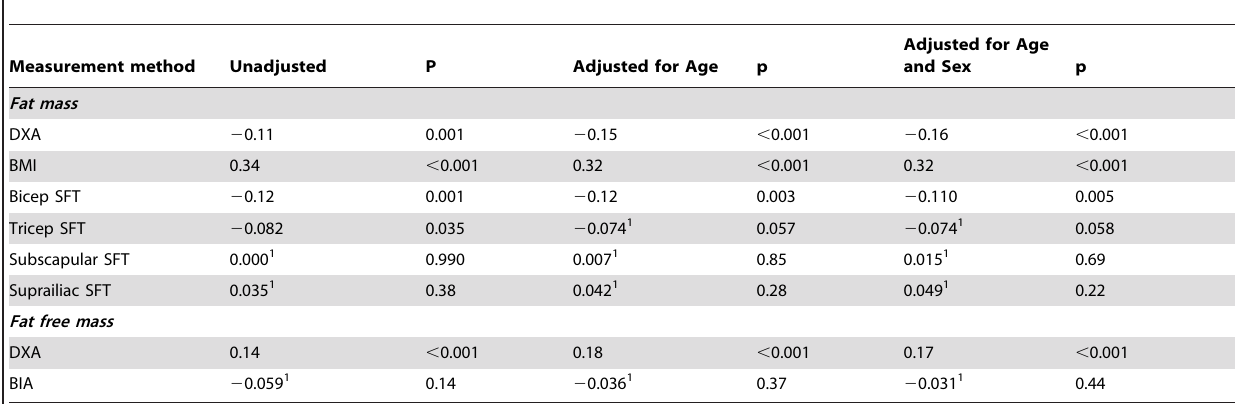
Table 2. Bland-Altman correlations, unadjusted and adjusted for age, and age and sex 1